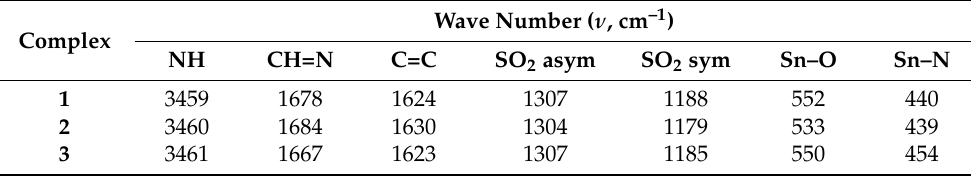
Table 2. Selected FTIR spectral data for some common groups in complexes 1 – 3